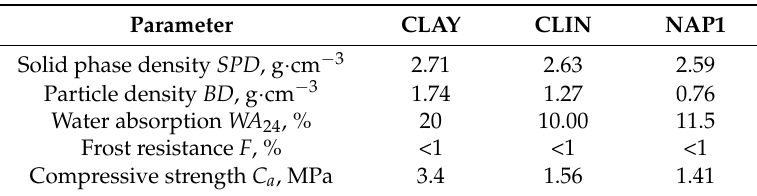
Table 1. Physical parameters of the